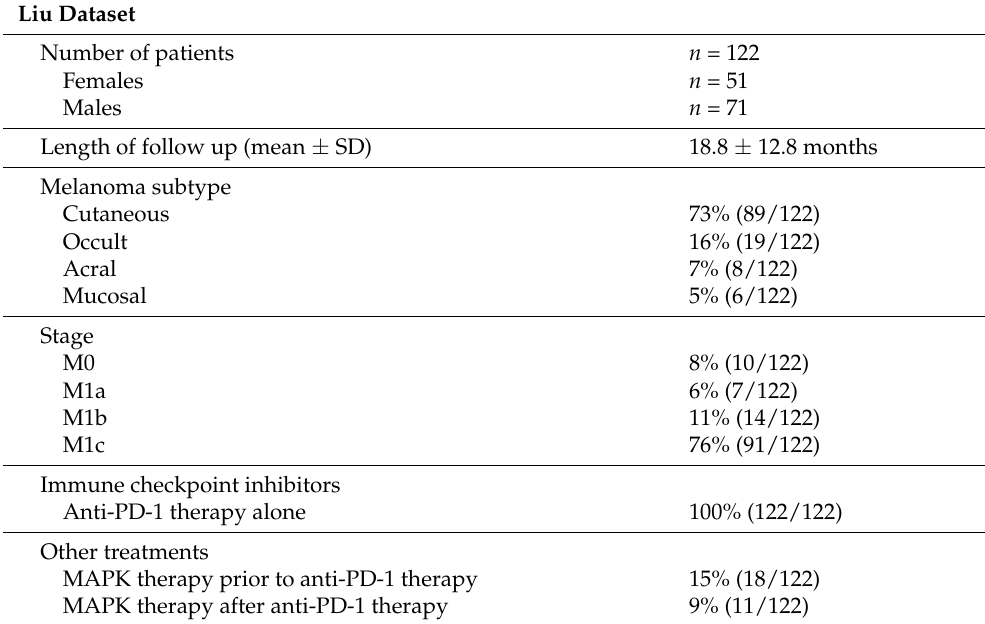
Table 1. Demographics of metastatic melanoma patients from the Liu, Van Allen, and Hugo datasets of RNAseq